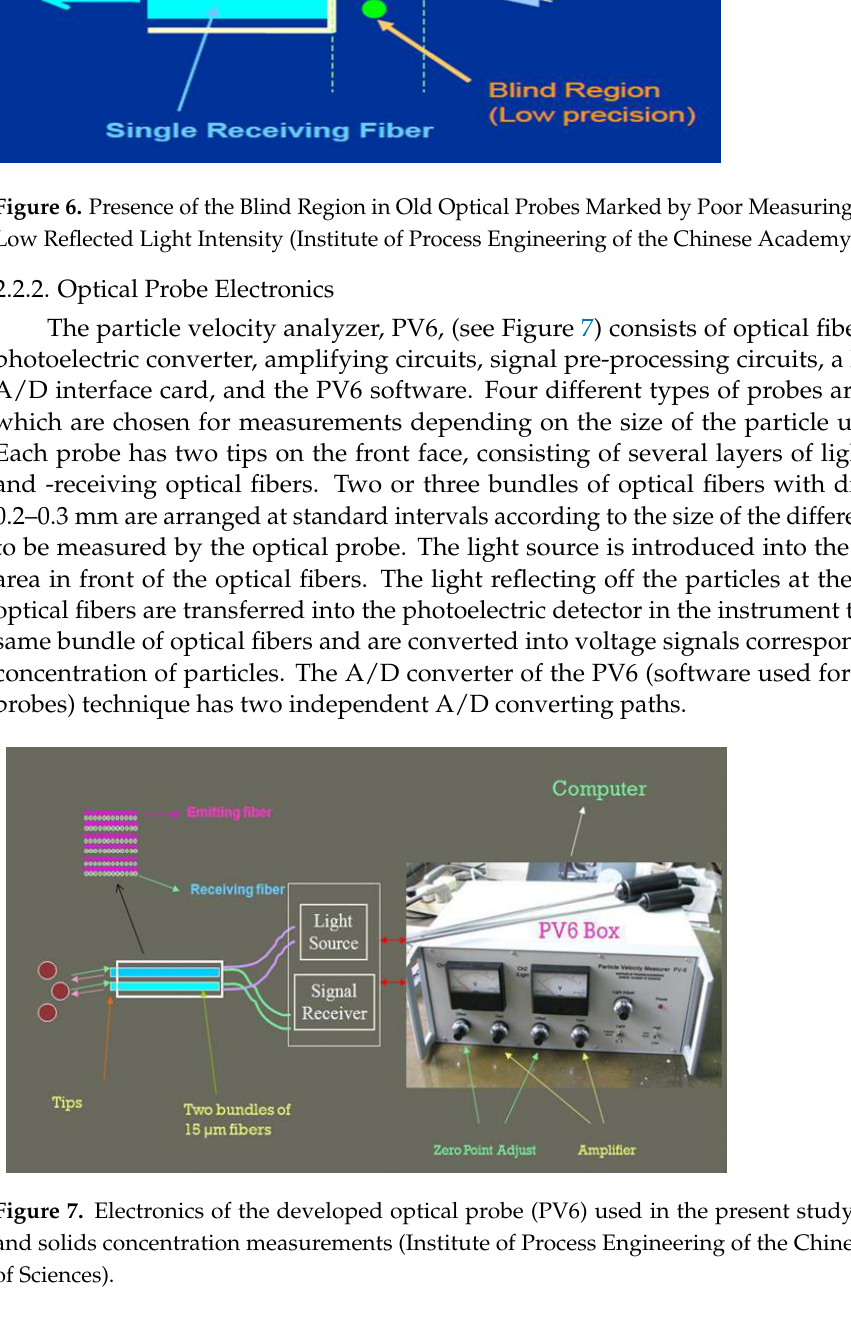
Figure 6. Presence of the Blind Region in Old Optical Probes Marked by Poor Measuring Volume and Low Reflected Light Intensity (Institute of Process Engineering of the Chinese Academy of Sci- ences).